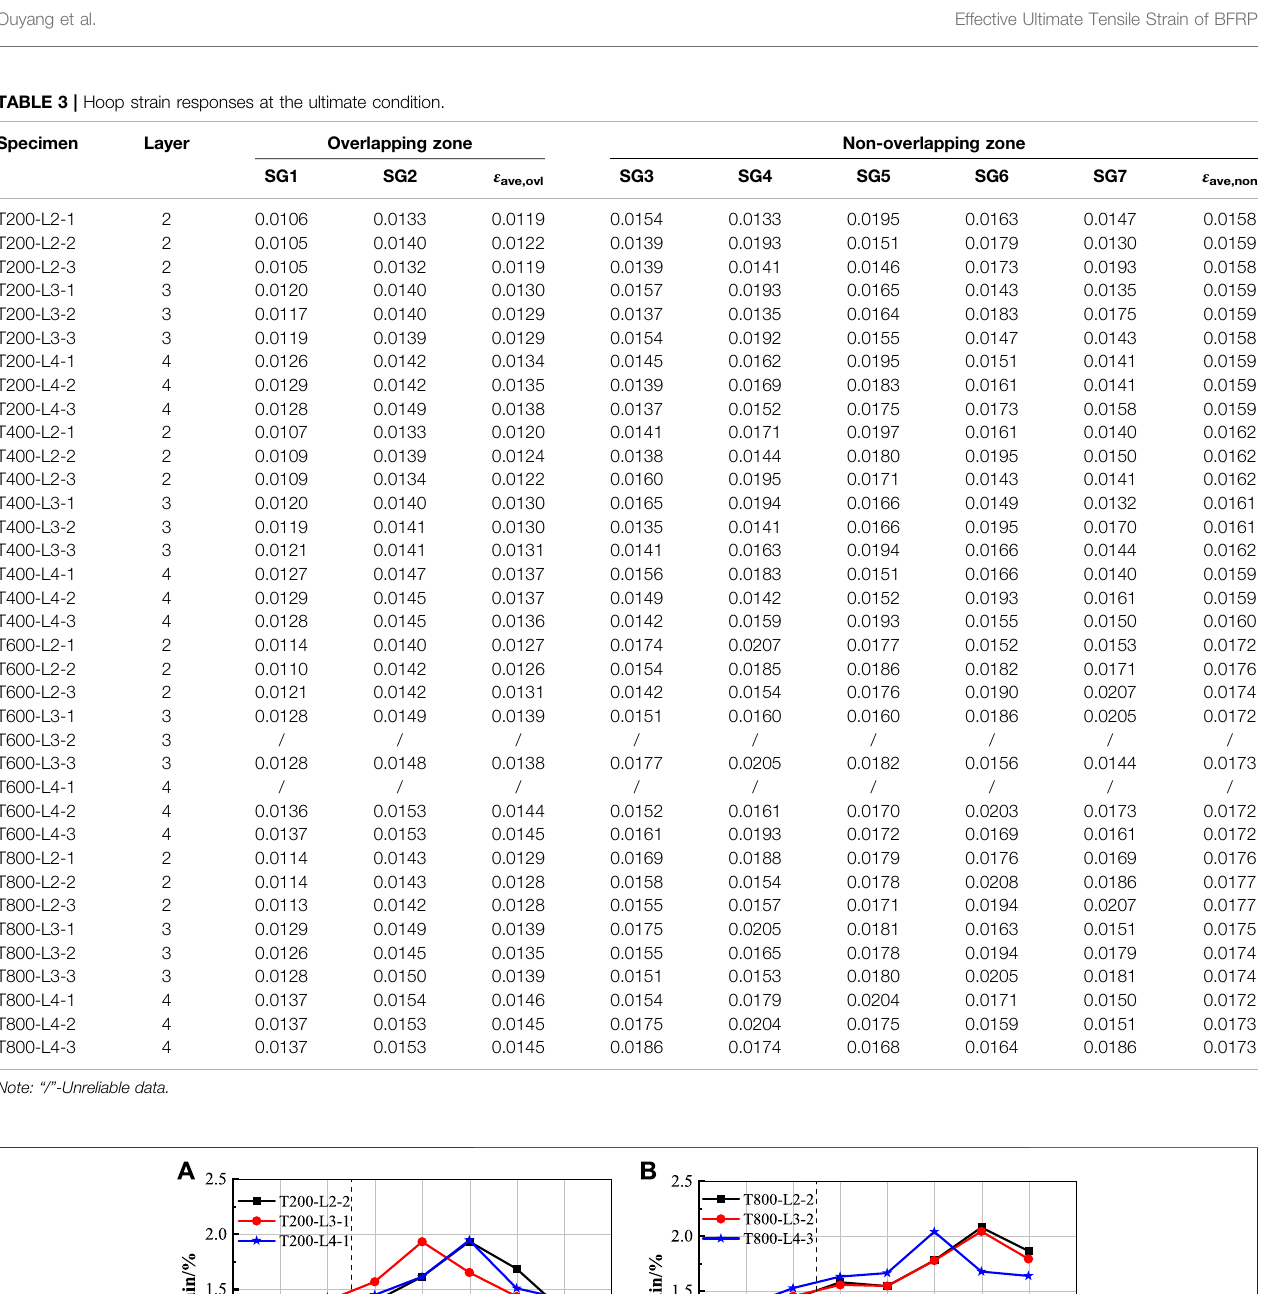
Frontiers in Materials |